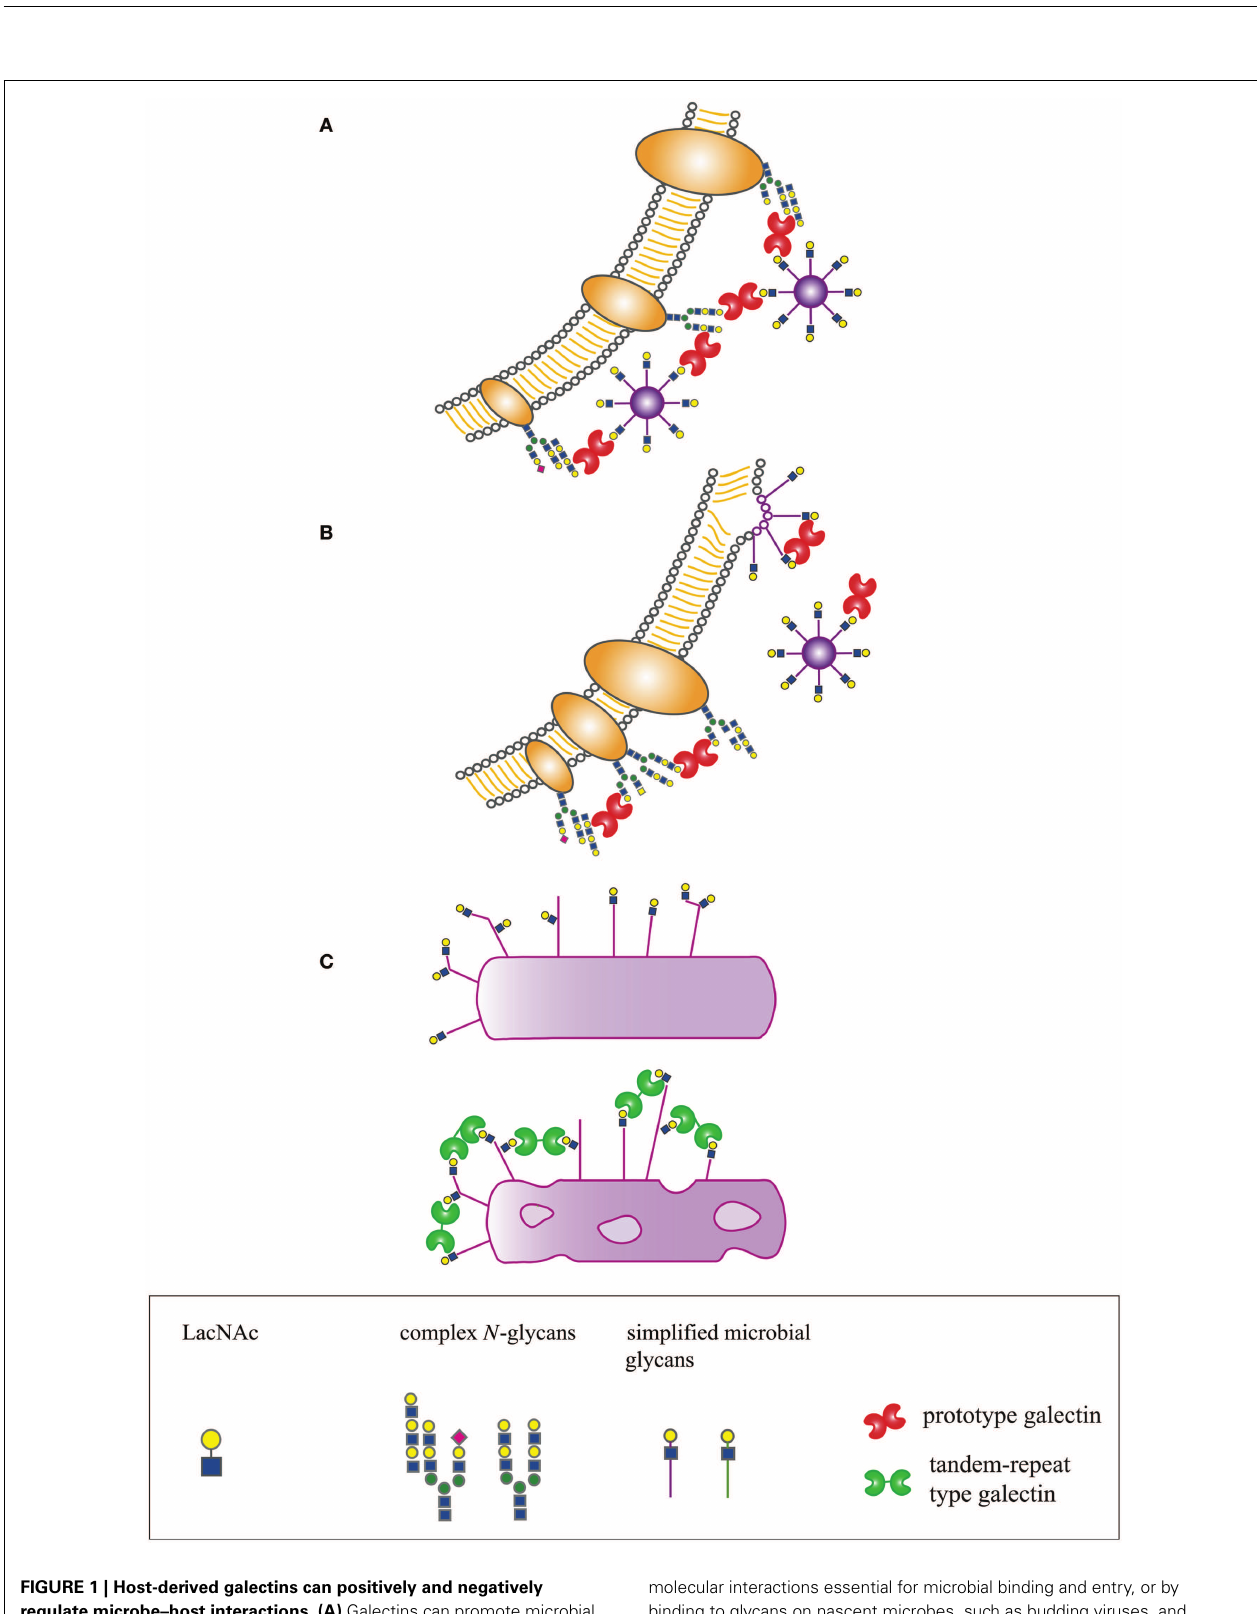
FIGURE 1 | Host-derived galectins can positively and negatively regulate microbe–host interactions . (A) Galectins can promote microbial attachment to and infection of host cells by bridging pathogen glycans to host cell surface glycans. (B) Galectins can inhibit microbial attachment and infection by binding to host or microbial glycans and blocking